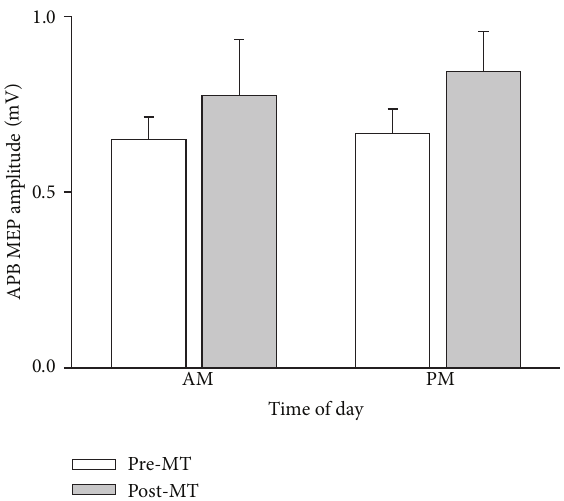
Figure 5: Salivary cortisol concentration is higher in the morning than the evening. Pre-MT salivary cortisol concentration in the morning was significantly greater than all other samples ( ∗ 𝑃 < 0.001 ). Post-MT salivary cortisol concentration in the morning was significantly greater than both evening samples, but significantly less than pre-MT morning concentration ( # 𝑃 = 0.008